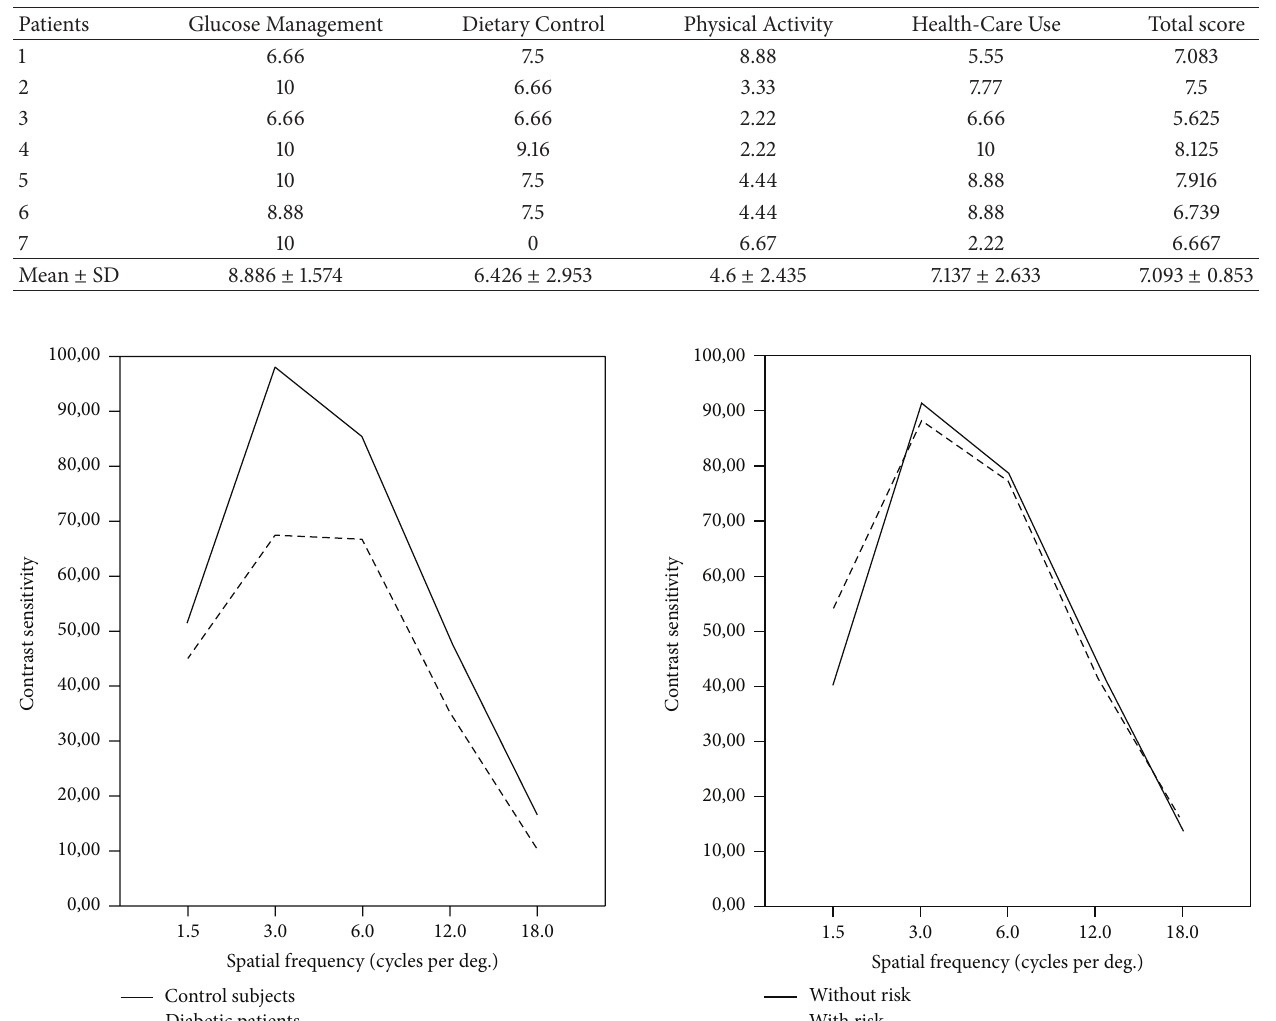
Table 2: Scoring of Diabetes Self-Management Questionnaire (DSMQ) in diabetic patients.